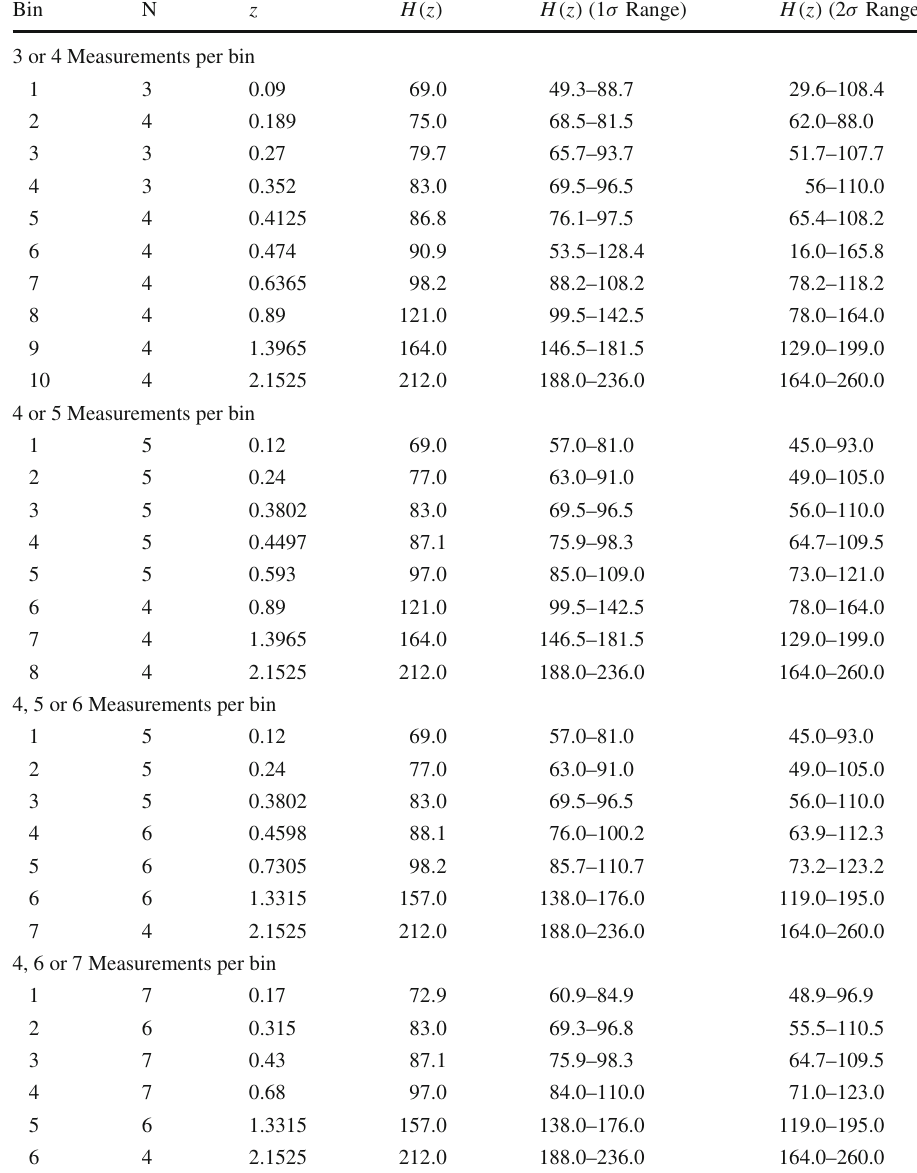
results for 37 reduced Redshift measurements, where the unit